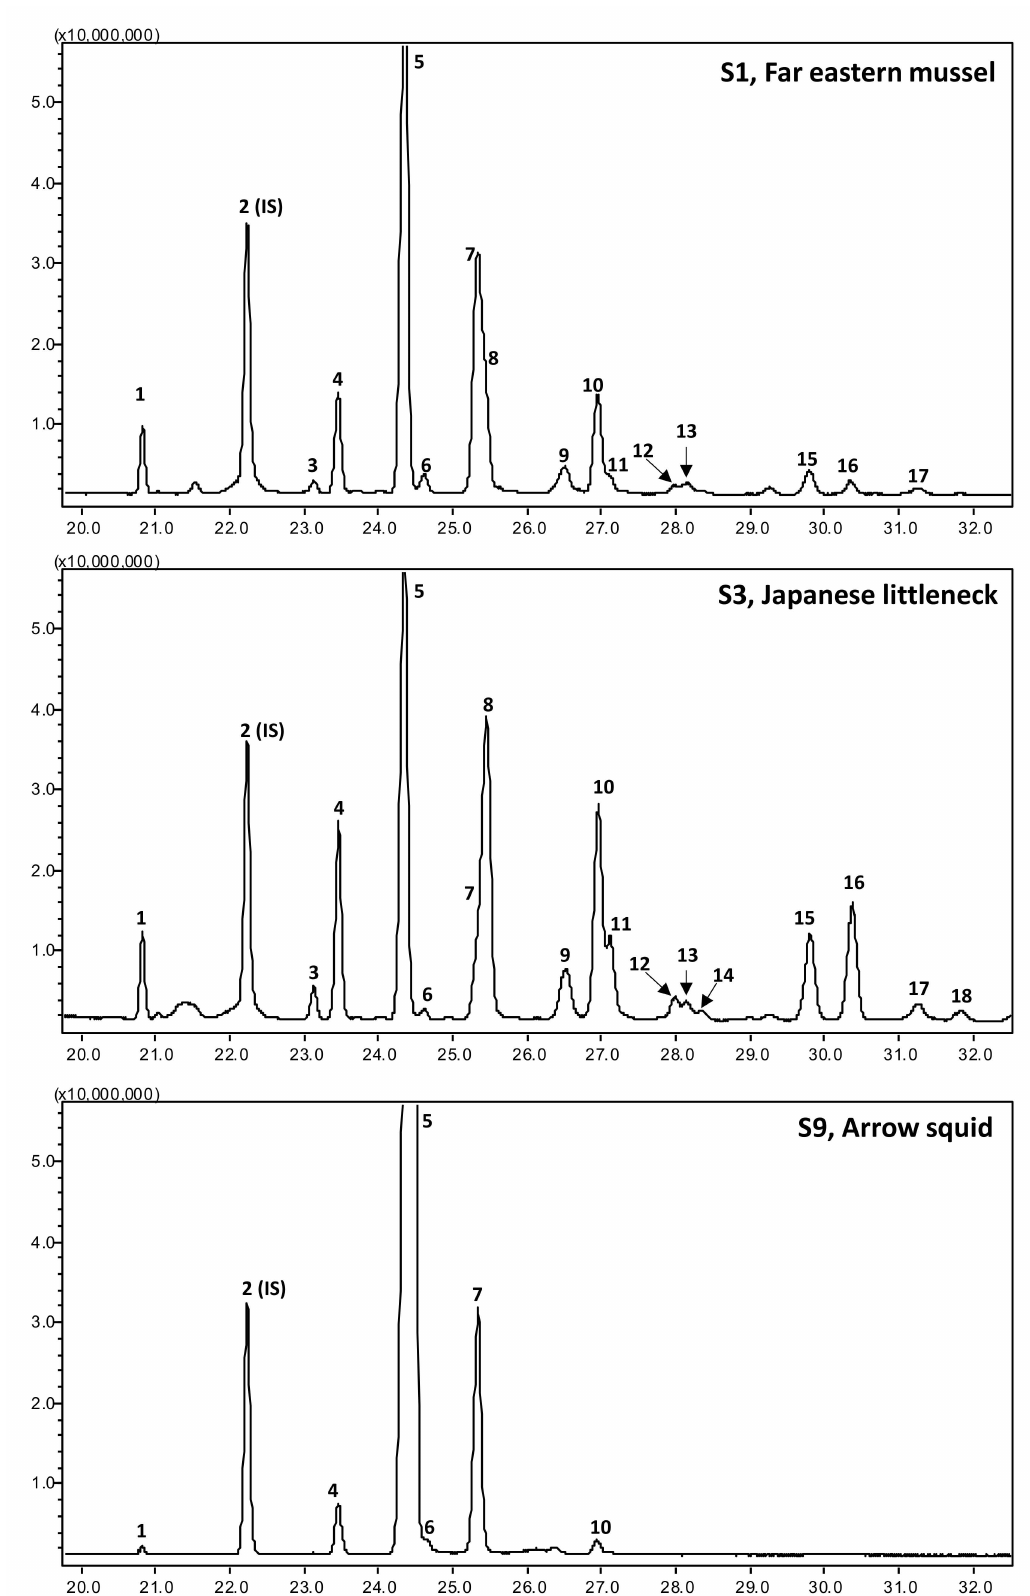
Figure 2. The representative gas chromatography (GC), mass spectrometry (MS), and total ion chromatograms (TIC) of the sterols of the far eastern mussel, Japanese littleneck, and arrow squid. The peak numbers (1 to 18) correspond to Table 2. IS: internal